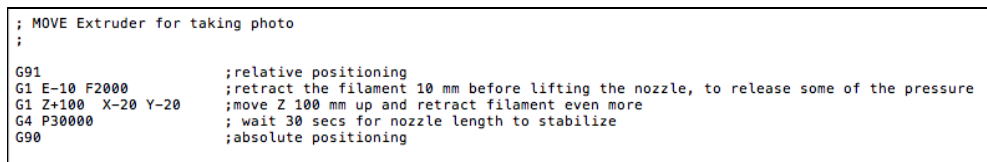
Figure 6. Python code for pausing and moving the extruder to take images.